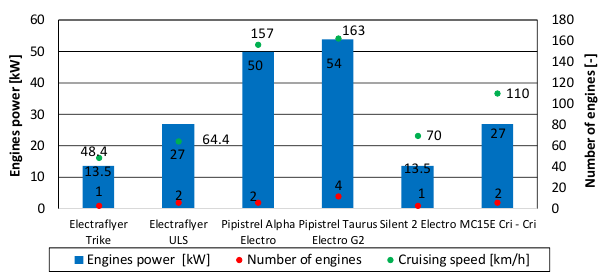
Fig. 12. The number of engines and their power